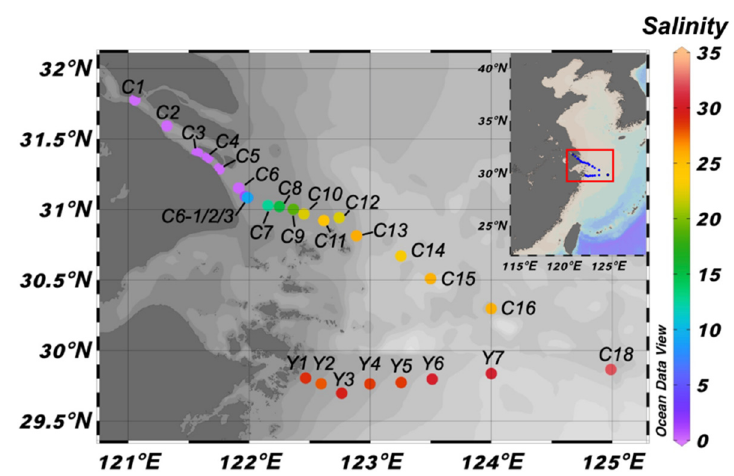
Figure 1. Map of the sampling stations in the Changjiang Estuary and its adjacent waters color-coded according to surface water salinity.